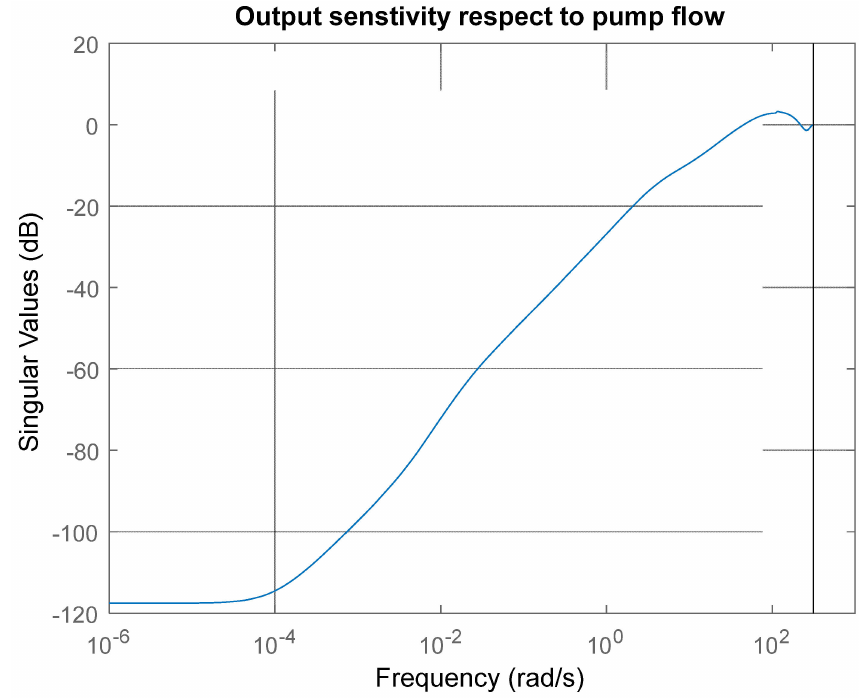
Figure 8. Output